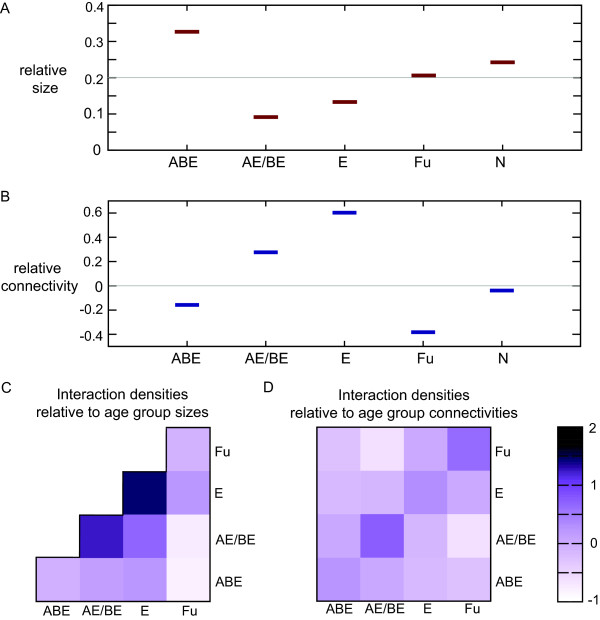
Interaction densities depend on size and connectivity of age groups. Interaction densities depend on age group sizes: the connectivity between age groups is normalized by the maximum possible connectivity: the number of connections if all members from the age groups would be interacting. This density is then again normalized by the interaction density of the entire network to allow for comparison between networks of different edges densities (see Materials and Methods for more detail). Age groups that are small and/or have low general connectivity will have low interaction densities with any age group. Interaction densities thus do not only represent a relative connectivity between a pair of age groups (or within one age group), it also reflects the overall connectivity as well as the size for each individual age group. A. Relative size for each age group in the LC network: the proportion of nodes that belong to this age group. The grey line denotes the relative size if all age groups would be of the same size. ABE and Fu are the largest groups. N is the group of proteins that are not assigned to an eggNOG family. B. Relative connectivity for each age group in the LC network, calculated as follows: log2 (avg(degreeage group) / avg(degreenetwork)). The grey line denotes the relative connectivity if it would have been the same for all age groups. Age groups ABE and Fu have a relatively low degree. N is the group of proteins that are not assigned to an eggNOG family. C. Interaction densities between age groups in the LC network: age groups ABE and Fu have in general low interaction densities with each age group reflecting their large size and low connectivity rather than a specific relation between two age groups. D. An improved method of calculating interaction densities: connectivity normalized by expected connectivity (see Materials and Methods for more detail). These densities are independent of the age groups sizes or degree and represent only a specific property of a pair of age groups. Our alternative measure ΔDnew is calculated based on these interaction densities.